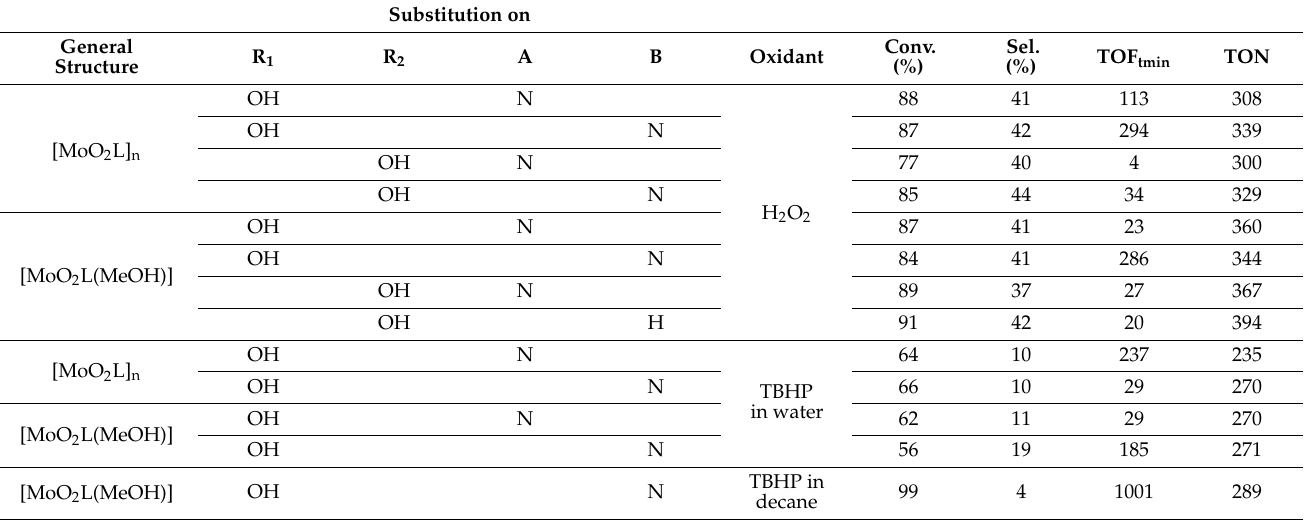
Figure 18. Schematic oxidation of carveol (C ol ) into carvone (C one ) and epoxides.